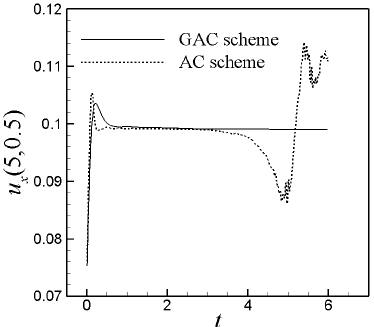
Figure 4. Comparison of the relative L 2 -error of τ xy and τ xx for y at position x = 5 at Wi = 15.0 with β = 0.5 and Re = 1.0, respectively.